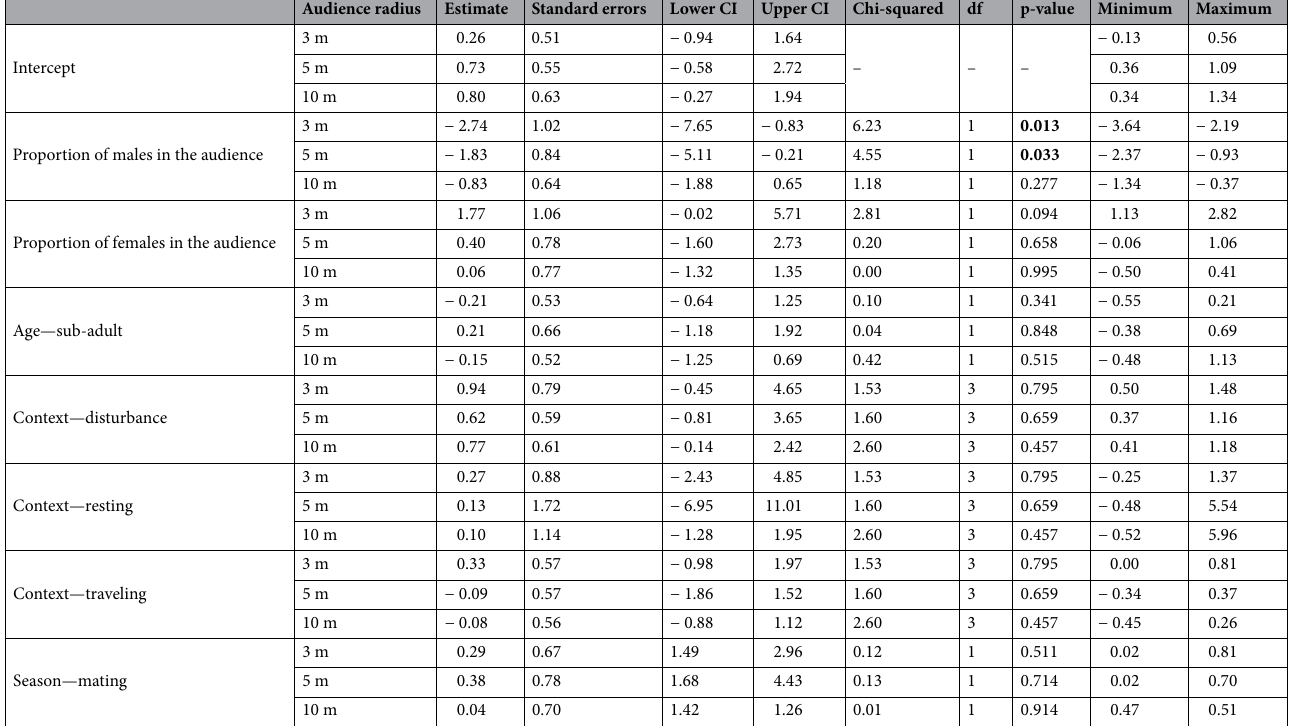
Table 1. Results of the models of the effects of audience composition within 3, 5 and 10 m radius, age, context and season on the probability that a male scent-mark when passing a marking spot. Significant p-values are in bold.